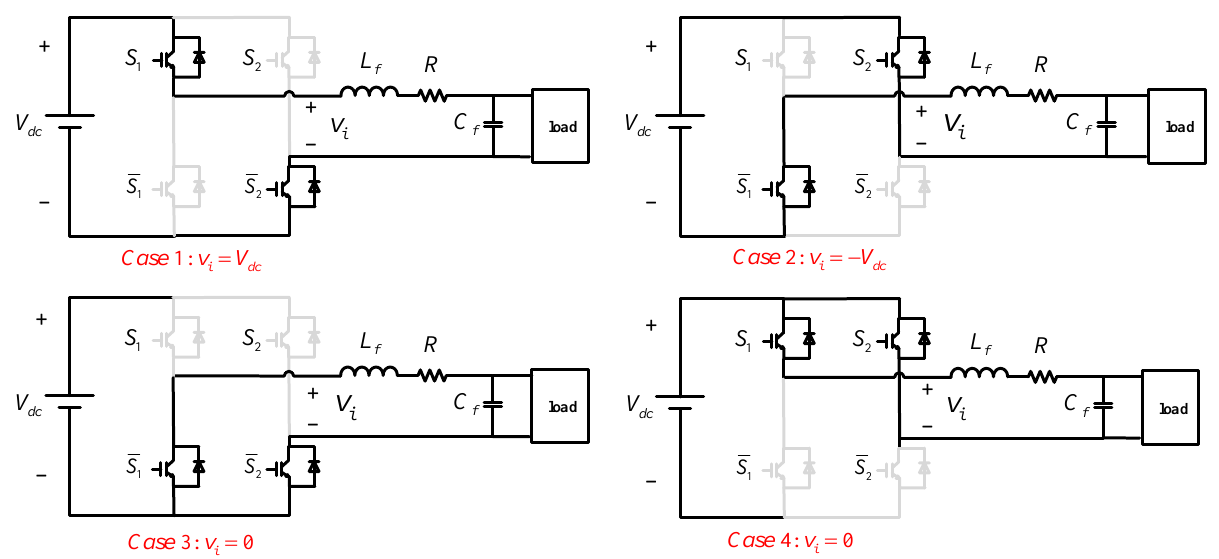
Figure 2. Operation modes of single-phase inverter with output LC